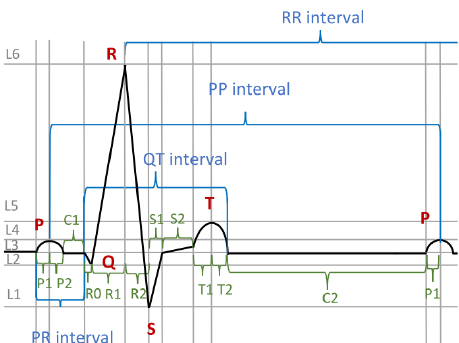
Figure 8. The ECG with interval